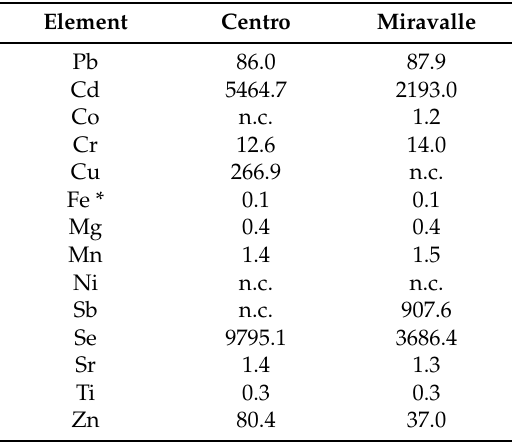
Table 2. Estimated values for EF.